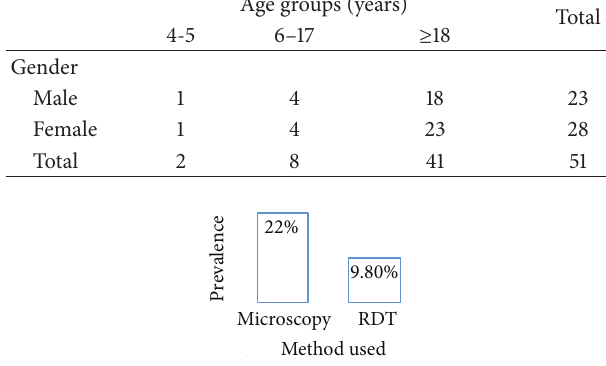
Figure 1: Prevalence of malaria at Aviation Medical Clinic, Murtala Mohammed Airport, Ikeja, Lagos State,